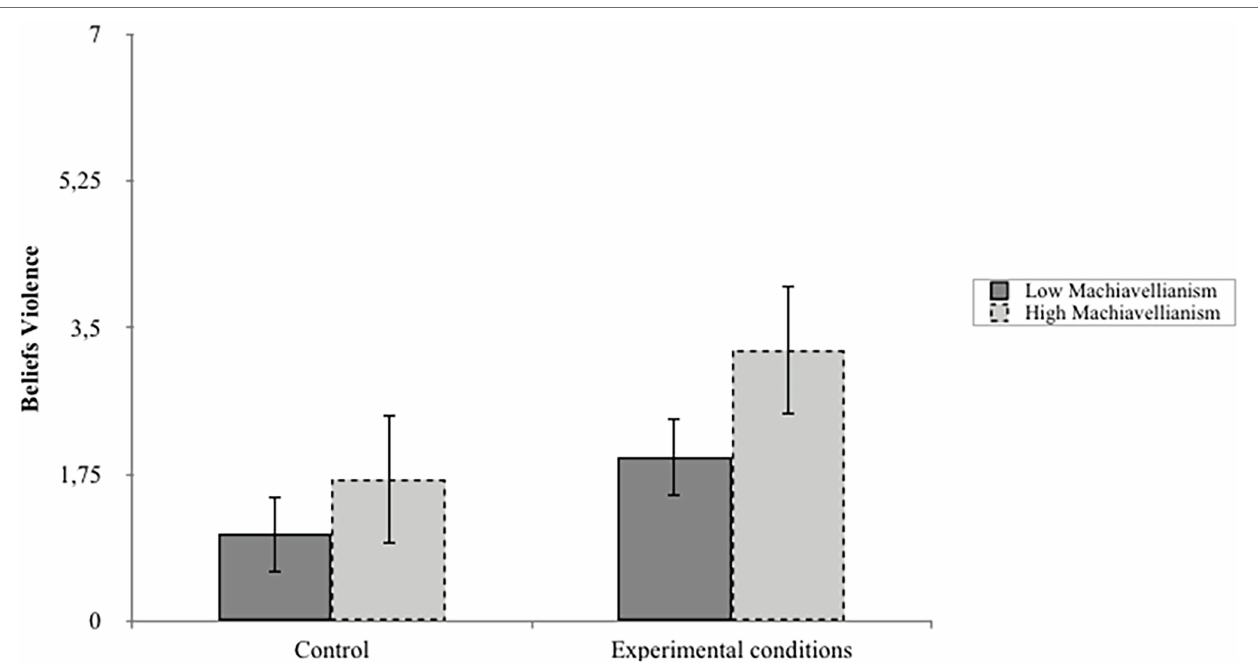
FIGURE 1 | The moderating role of Machiavellianism by narrative exposure on Homeland Liberation Alliance (HLA) Use of Violence.